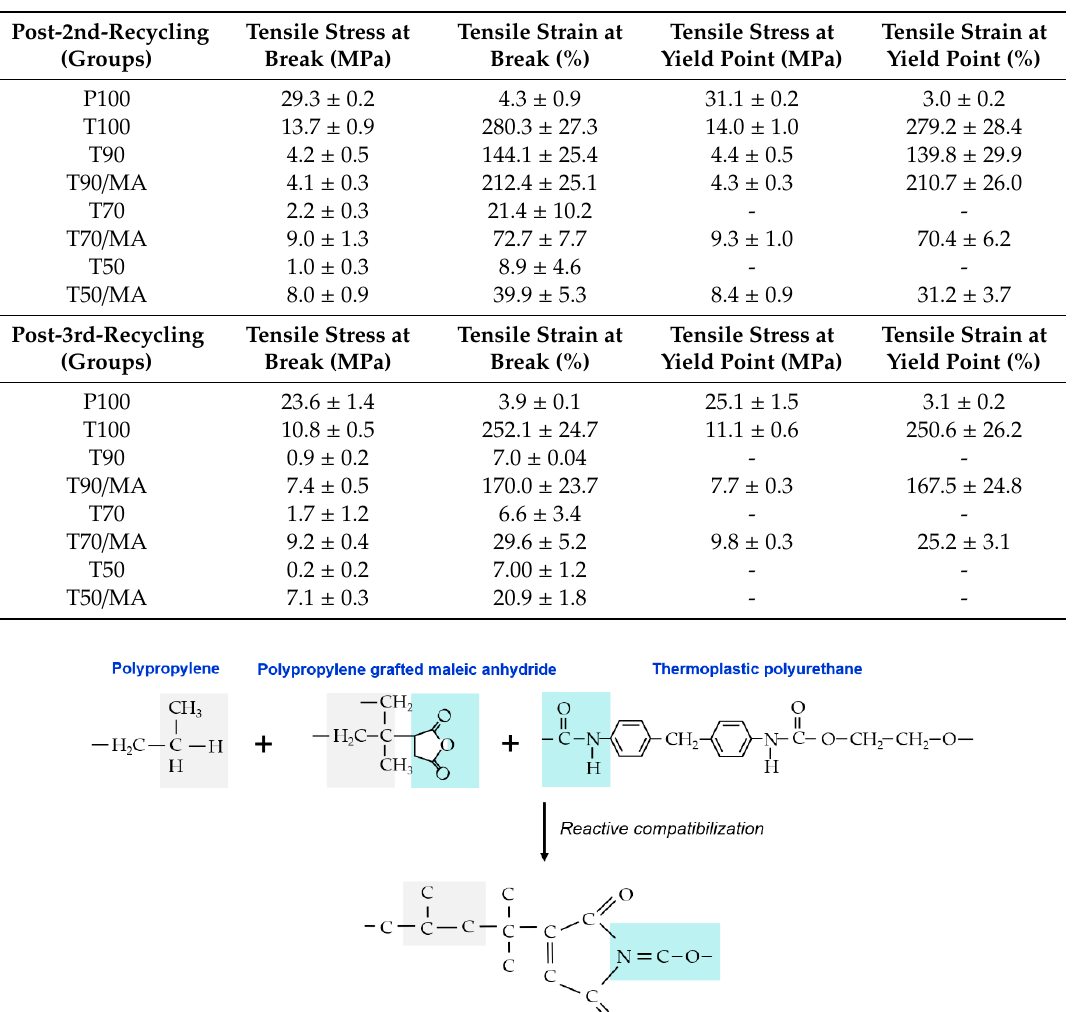
Table 2. Tensile stress and tensile strain of post-2nd-recycling and post-3rd-recycling T/P and T/P/MA blends.